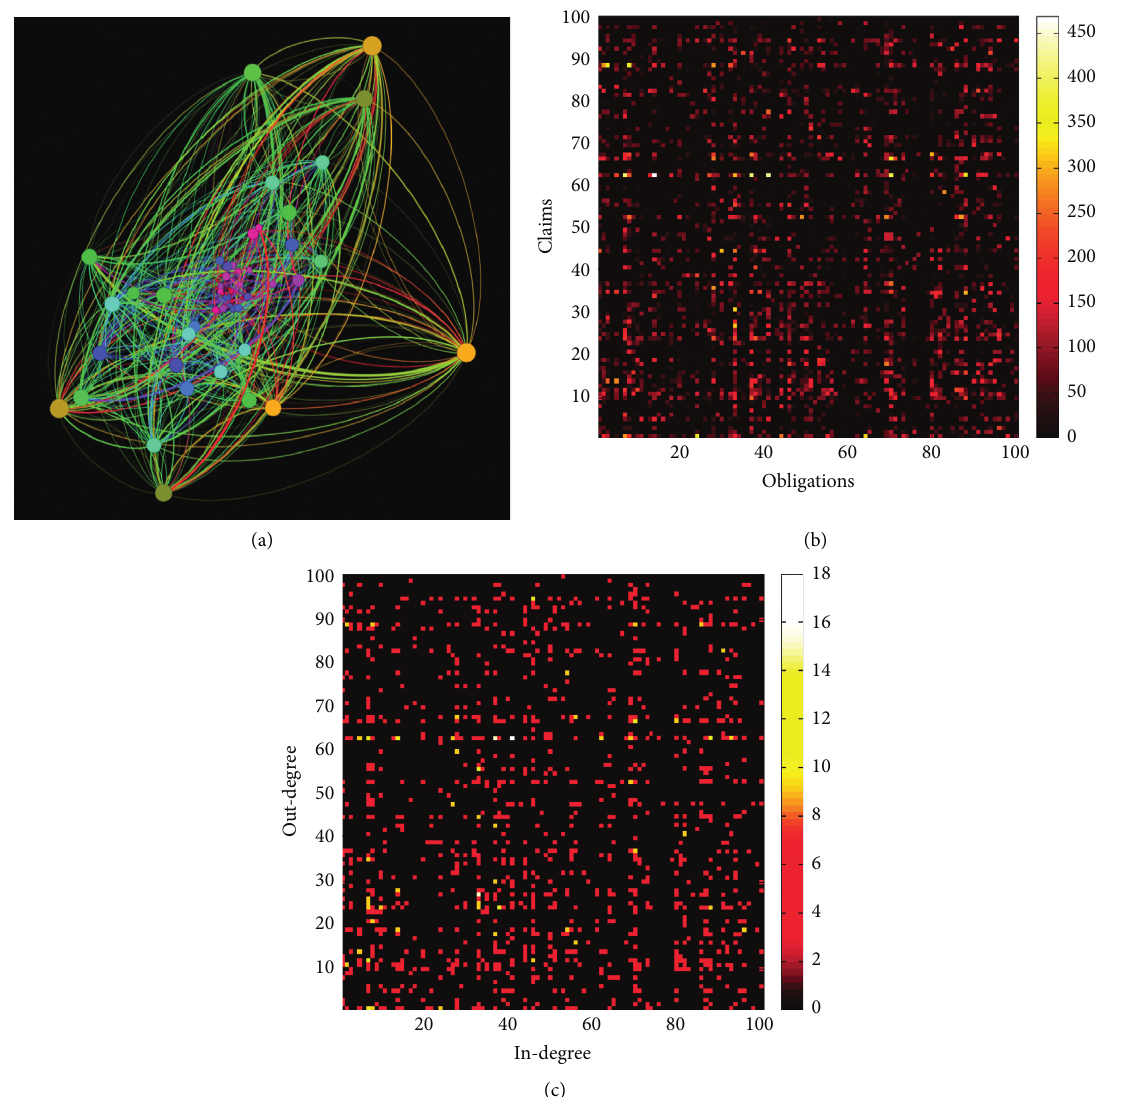
Figure 5: Organization of the interbank network in the simulation, with N ( 768 , 100 , 2 , 5 ) . The left panel is the graph of the interbank network (where the 100 biggest degrees are selected). The bilateral exposures matrix of the claims and obligations (top right side) and the bilateral exposures matrix of the out-degree and the in-degree (bottom right